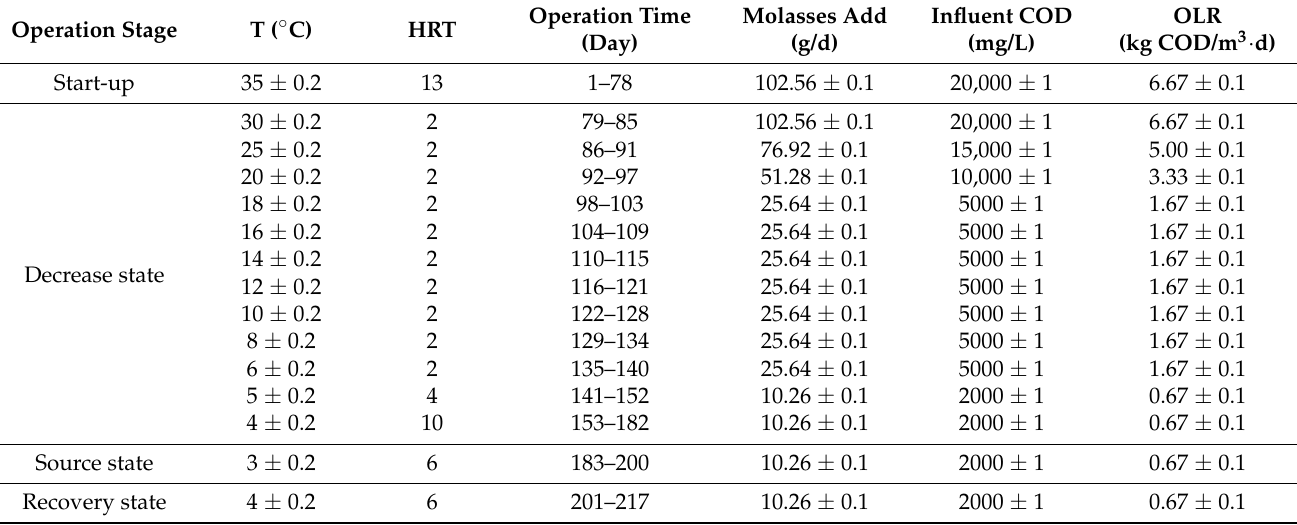
Table 1. Fixed-bed reactor operating